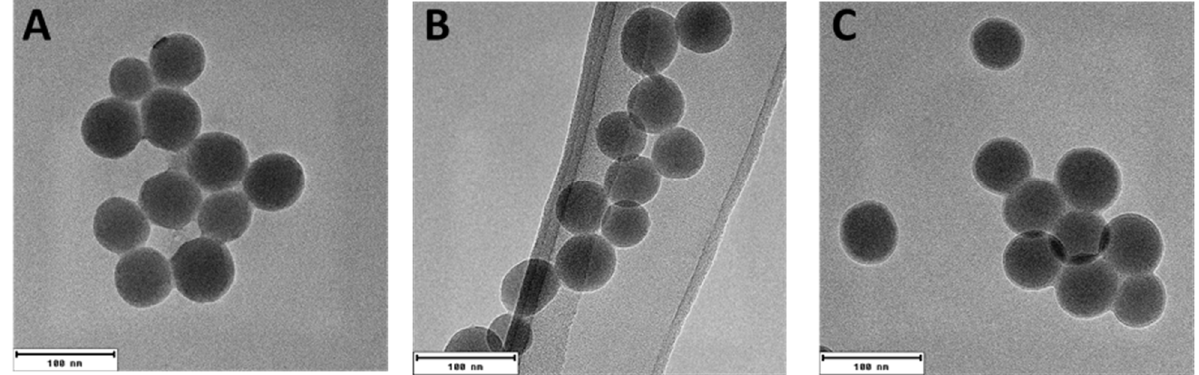
Figure 1. TEM images of the differently functionalized SiNPs for determination of primary particle size ( A ) SiNP, ( B ) SiNP_A, ( C ) SiNP_M, Size bar: 100 nm.